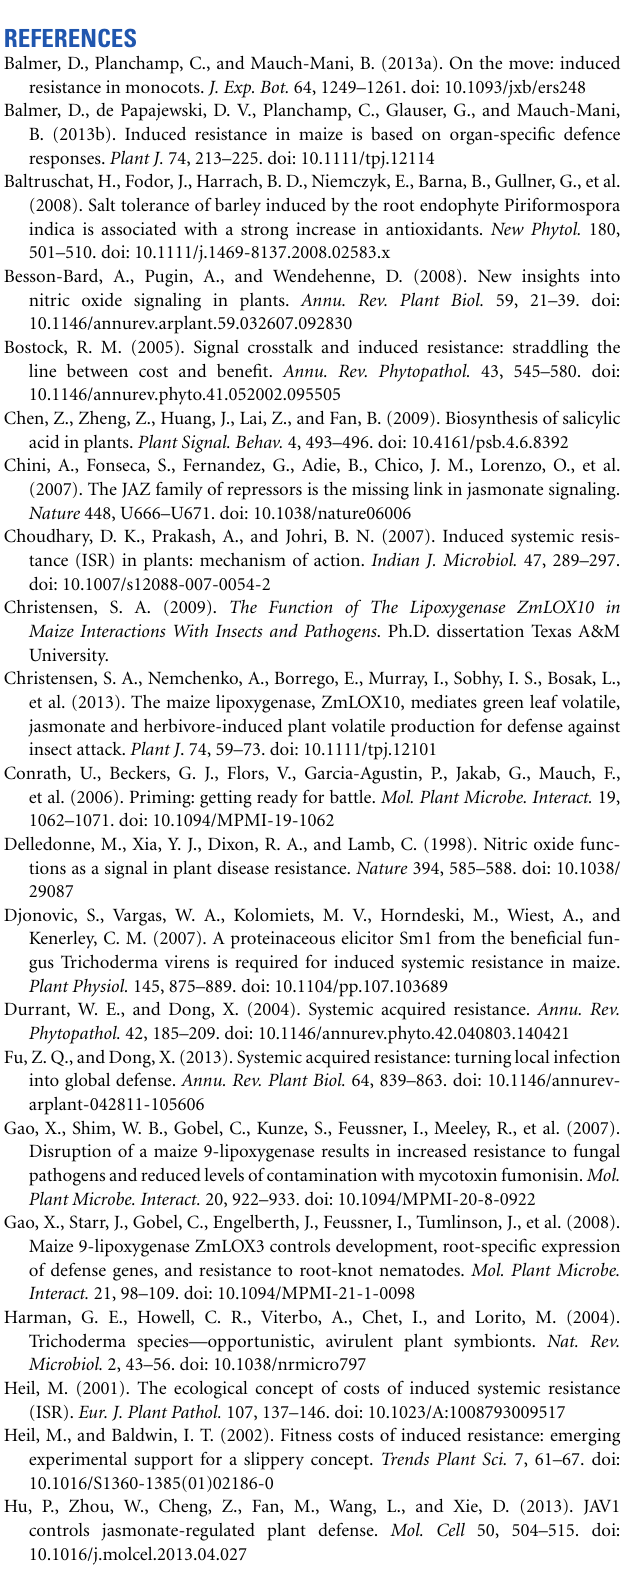
Supplementary Table 1 | Primers used in this study for RT-PCR and